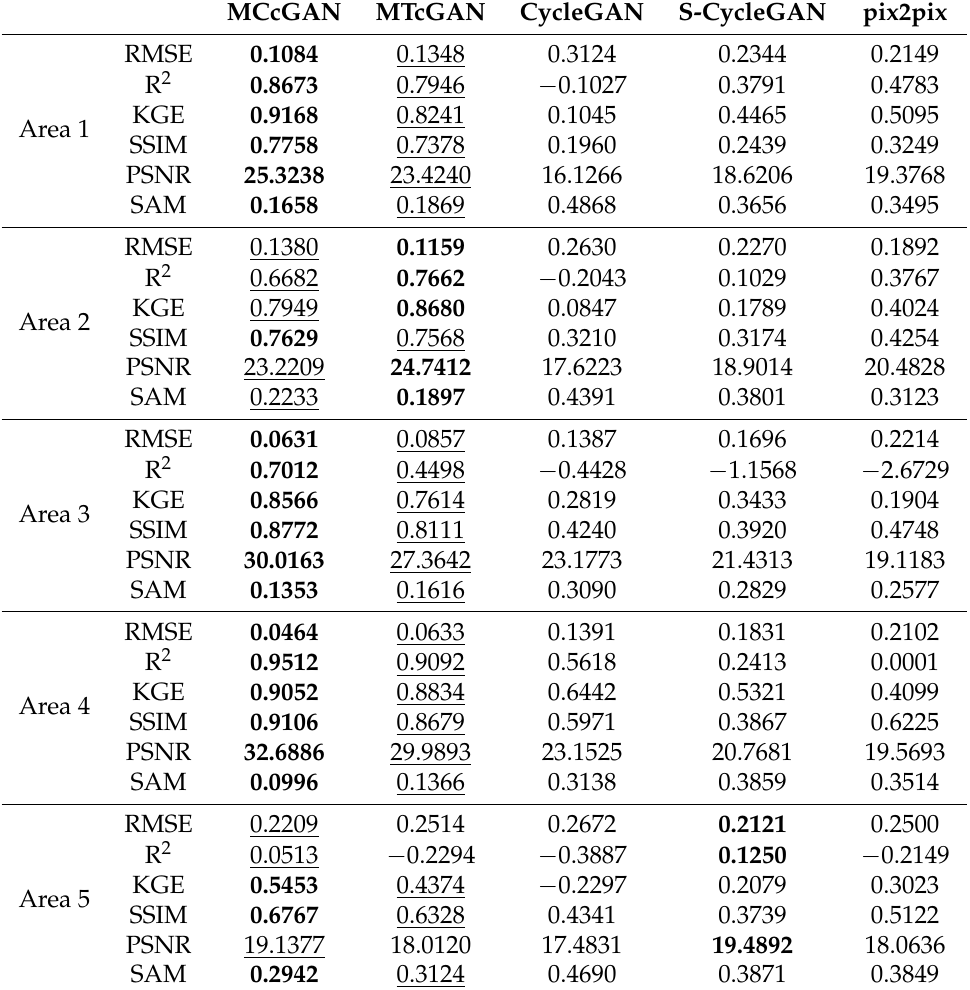
Table A8. The evaluation metrics for NDVI of different methods in different areas (the bold result is the best among the different metrics; the underlined is the second